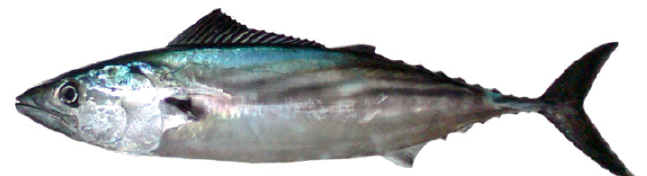
Figure 1. Specimen of South Pacific Bonito ( Sarda chiliensis chiliensis ).